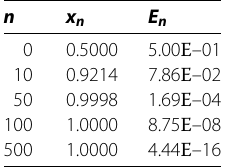
Table 1 Numerical results as regards Example 1